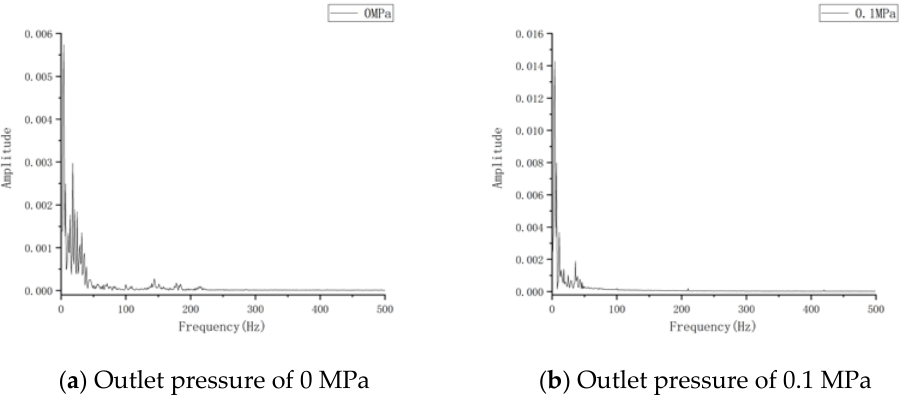
Figure 18. Experimental study on the pressure fluctuation in the pipeline in the frequency domain.